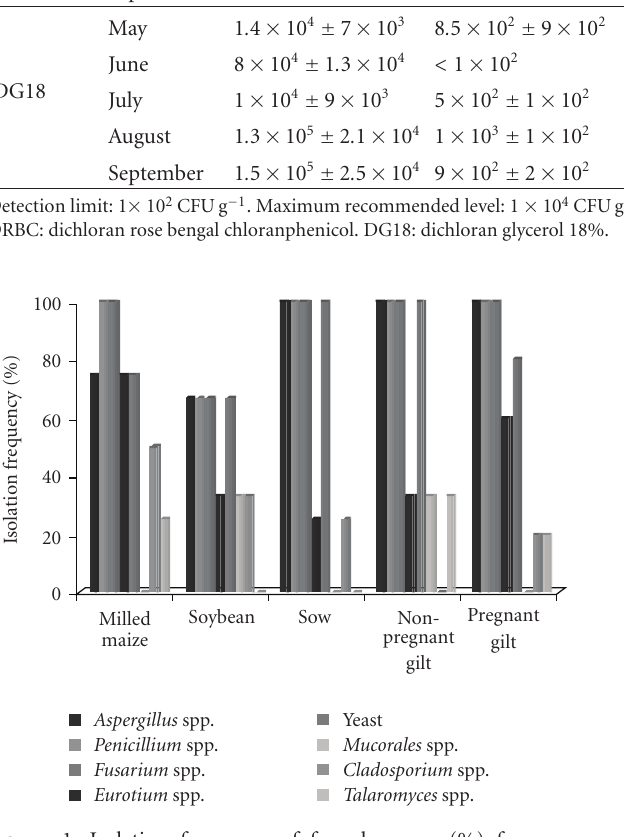
Figure 1: Isolation frequency of fungal genera (%) from raw materials and finished feed for sows at di ff erent reproductive stages.